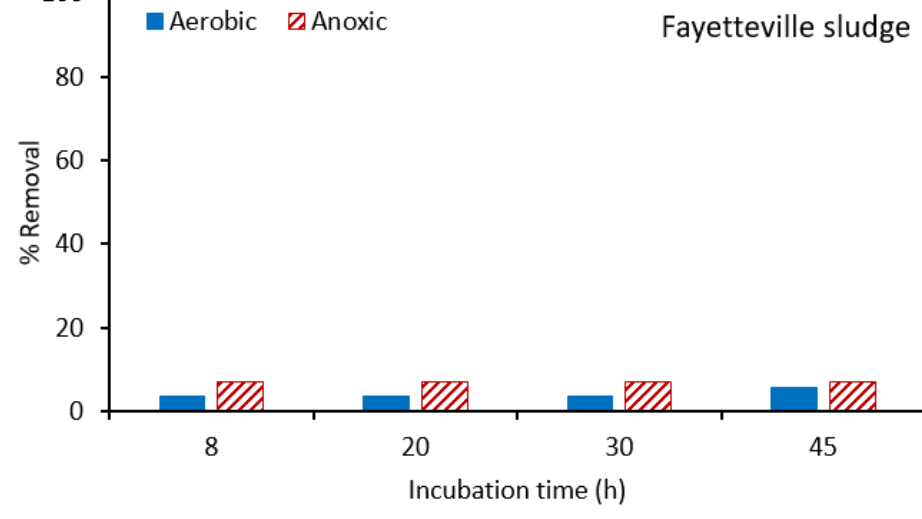
Figure 7. Percentage removal of atrazine in batch experiments where there is no mixing of the MLSS using Fayetteville sludge. The total suspended solids (TSS) in aerobic and anoxic tanks was 5958 and 4920 ± 600 mg/L, respectively.